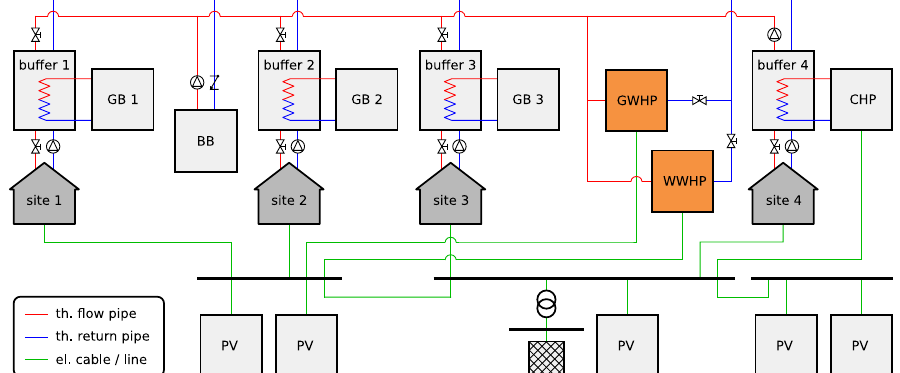
Figure 5. Schematic overview of the hybrid system layout for the suburban industrial area (GB, gas boiler; BB, biomass boiler; GWHP, ground water heat pump; WWHP, waste water heat pump; PV, photovoltaic module; CHP, combined heat and power plant). The components targeted by the design optimization process are highlighted in